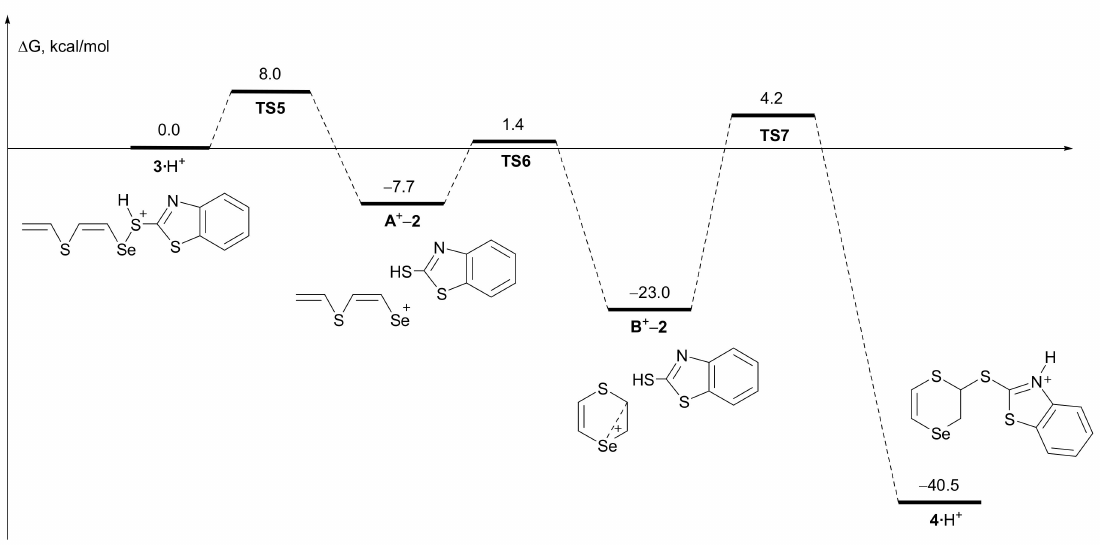
Figure 3. Schematic representation of the process of intramolecular rearrangement 3 · H + → 4 · H + according to B3LYP/ 6-311+G(d,p).